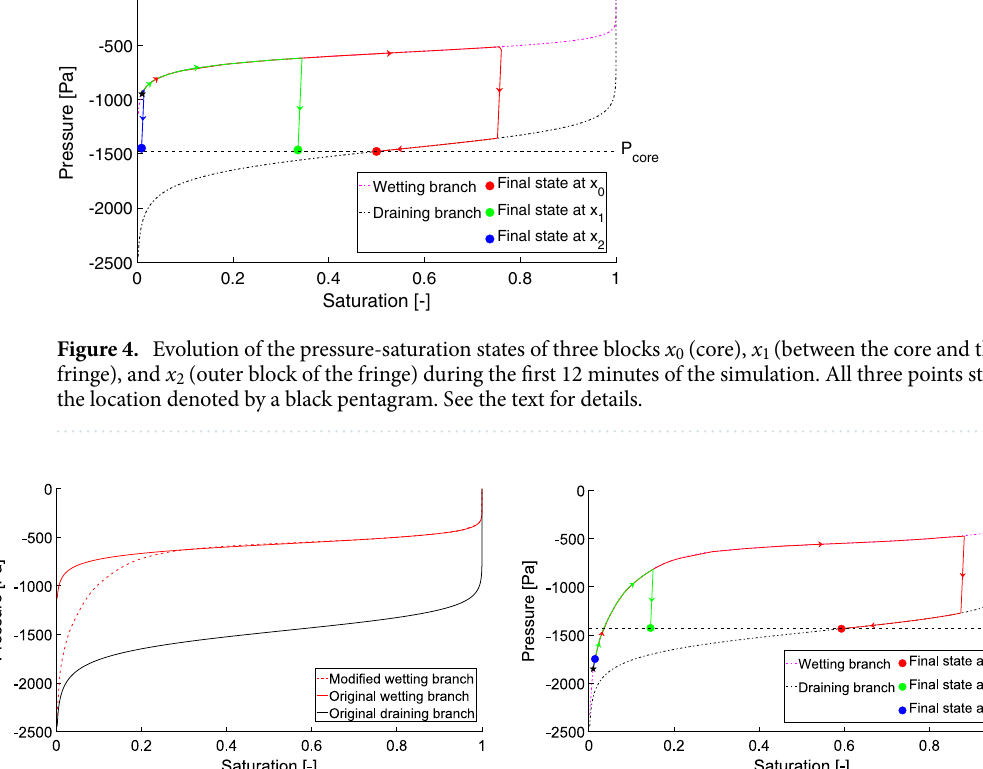
Figure 5. Lateral expansion of the fingers. Left panel: The modified retention curve of 30/40 sand. Original van Genuchten wetting curve (full red line) and its modification by a cubic spline (dotted red line). The draining branch (full black line) was not modified. Right panel: Evolution of the pressure-saturation states of three blocks x 0 (core), x 1 (between the core and the fringe), and x 2 (outer block of the fringe) during the first 20 minutes of the simulation. All three points started at the location denoted by a black pentagram. See the text for